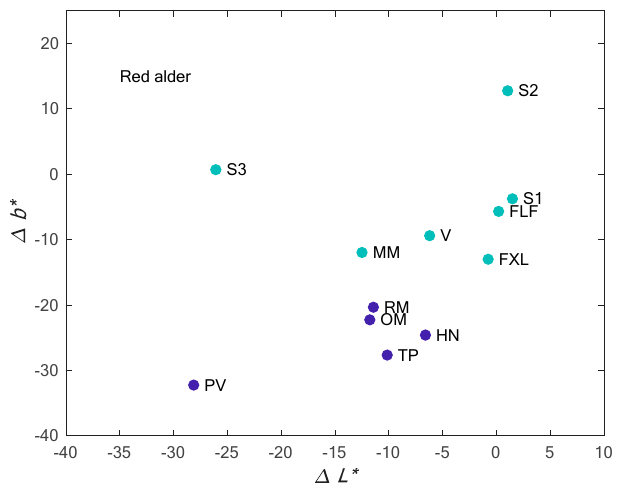
Figure 12. Cluster results according to linkage distance calculated with MANOVA using 18-month Δ L *, Δ a *, and Δ b * values for red alder wood.